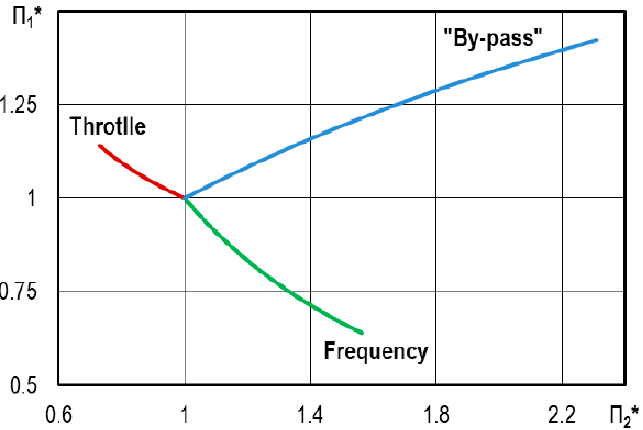
Figure 2. Presenting the relationship between the criterions Π 1 * and Π 2 *, including the parameters of flow control.